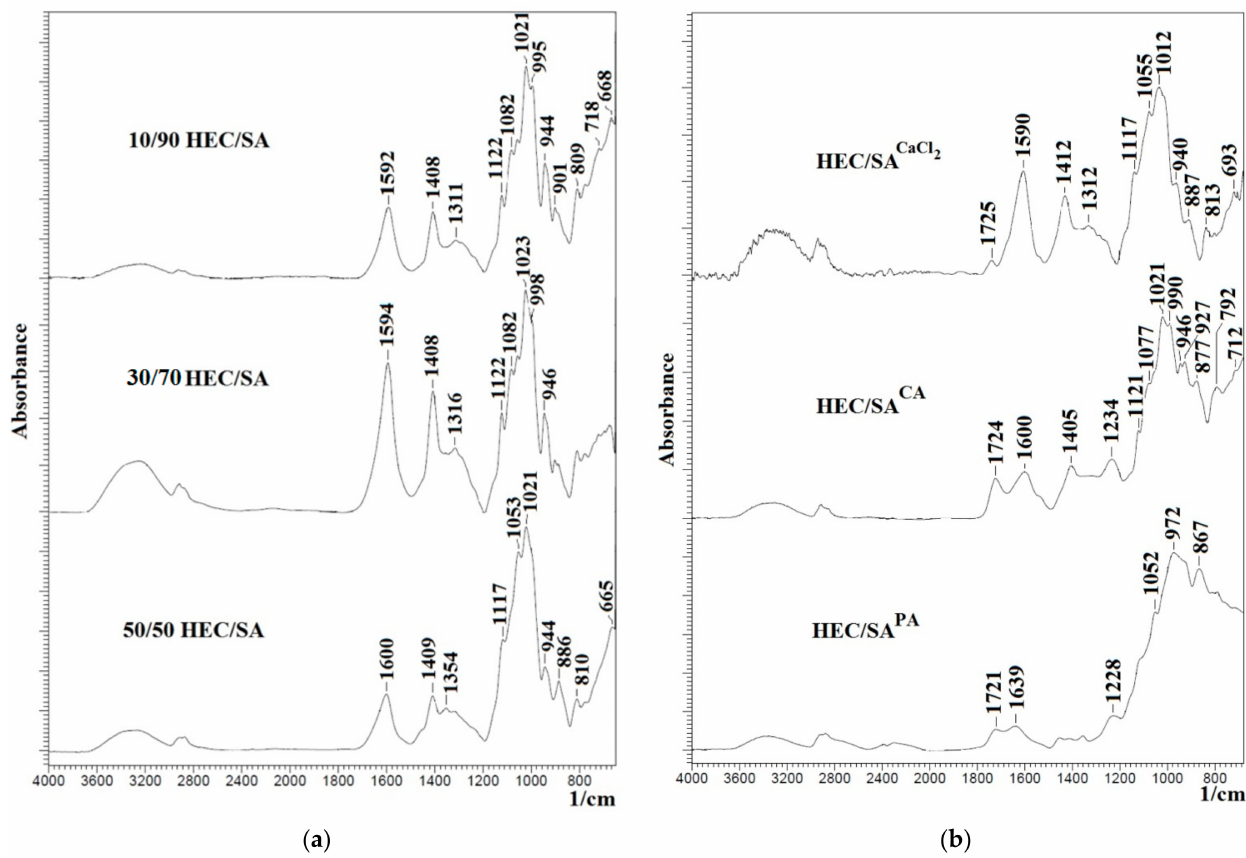
Figure 3. The Fourier-transform infrared (FTIR) spectra for ( a ) the HEC/SA membranes with different polymer weight ratios (10/90, 30/70, and 50/50 wt.%) and ( b ) the cross-linked HEC/SA (30/70) membrane with calcium chloride (CaCl 2 ) and phosphoric (PA) and citric (CA)